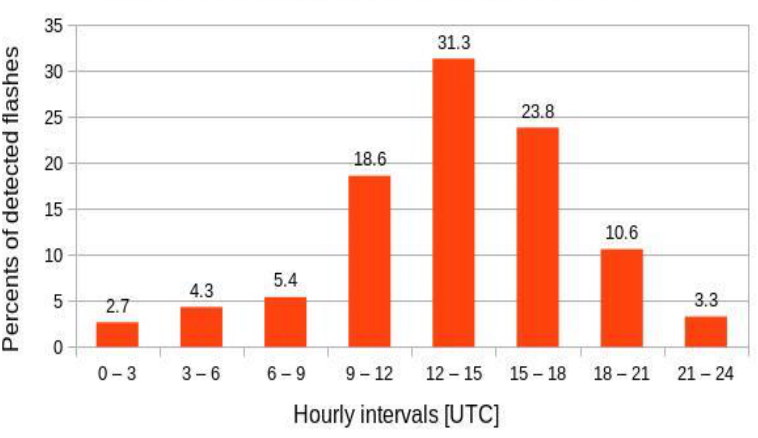
Figure 7. Diurnal distribution (in %) of flashes over the studied domain according to ATDnet for the period 2012 – 2021.